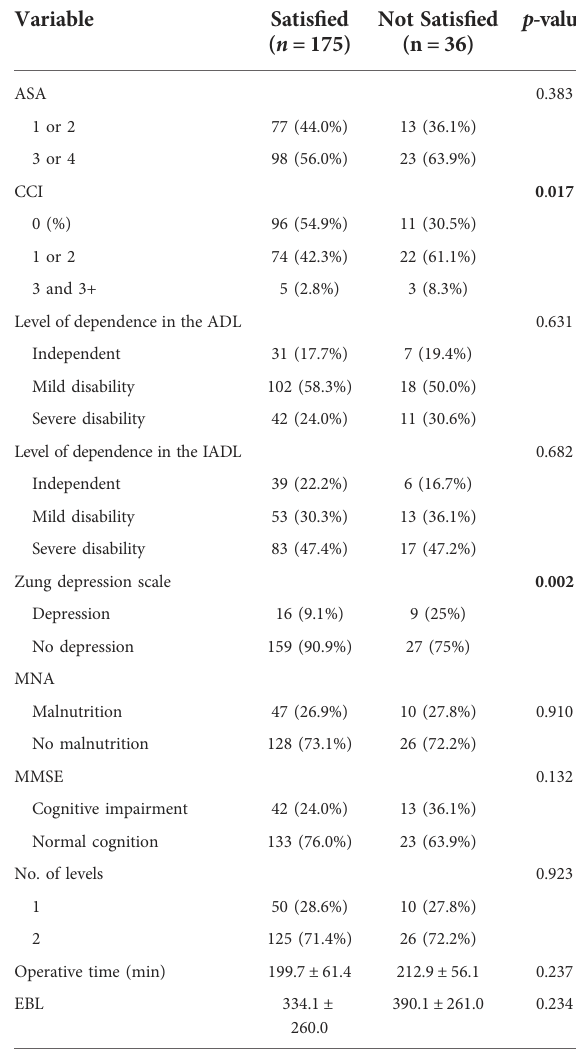
TABLE 3 CGA scores and procedure-related variables of patients in the two